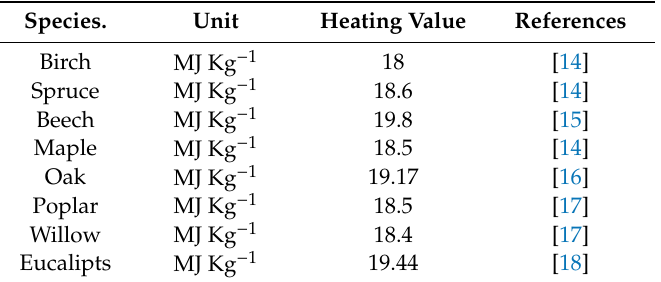
Table 1. Fuel quality parameters of di ff erent